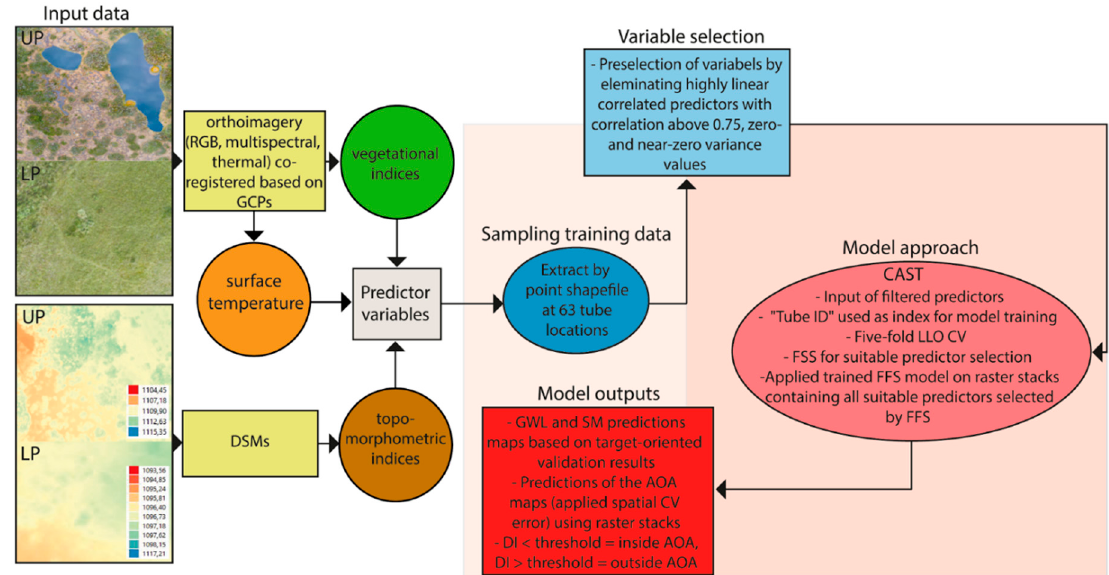
Figure 4. A simplified flowchart of the methodological approach, including model inputs, sampling, variables selection, model approach, and model outputs.